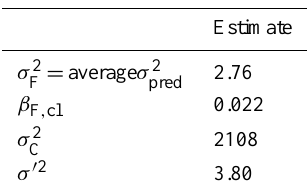
Table 6. Variance components used for combining the rock and debris